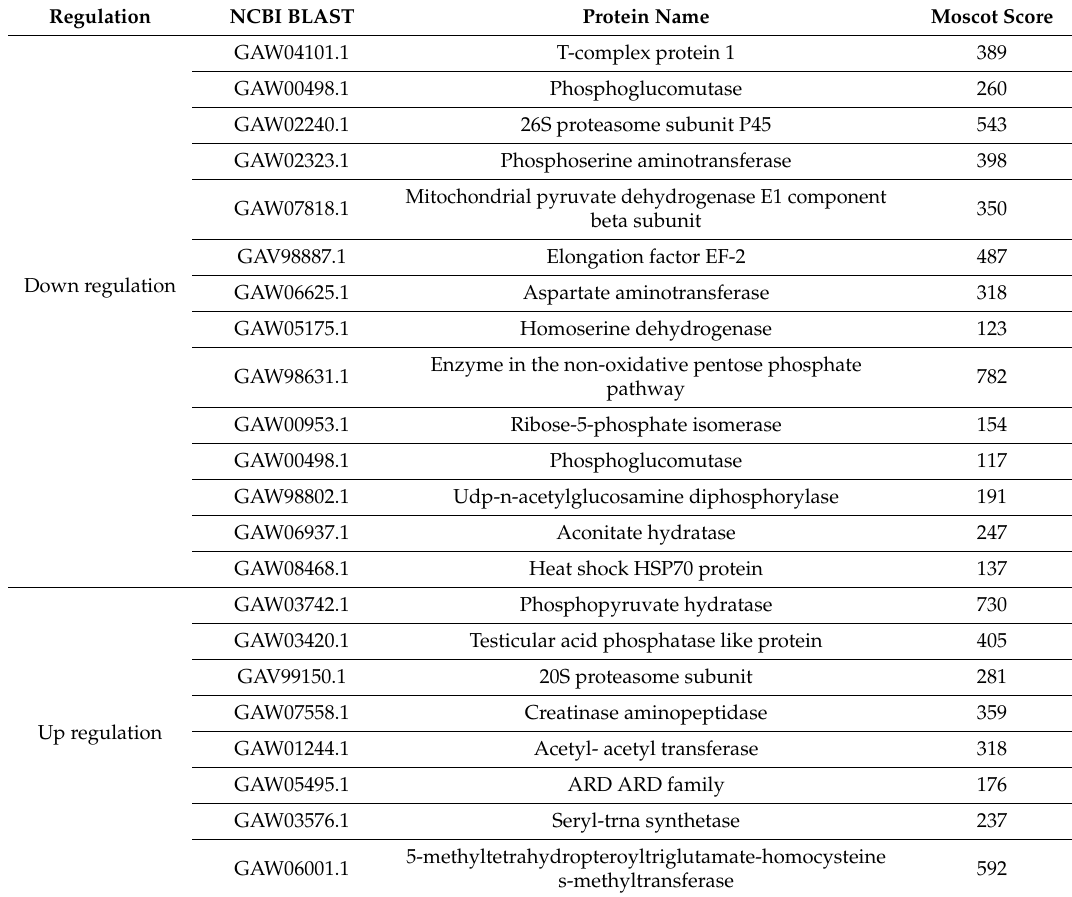
Table 2. Protein expression identified in LL versus